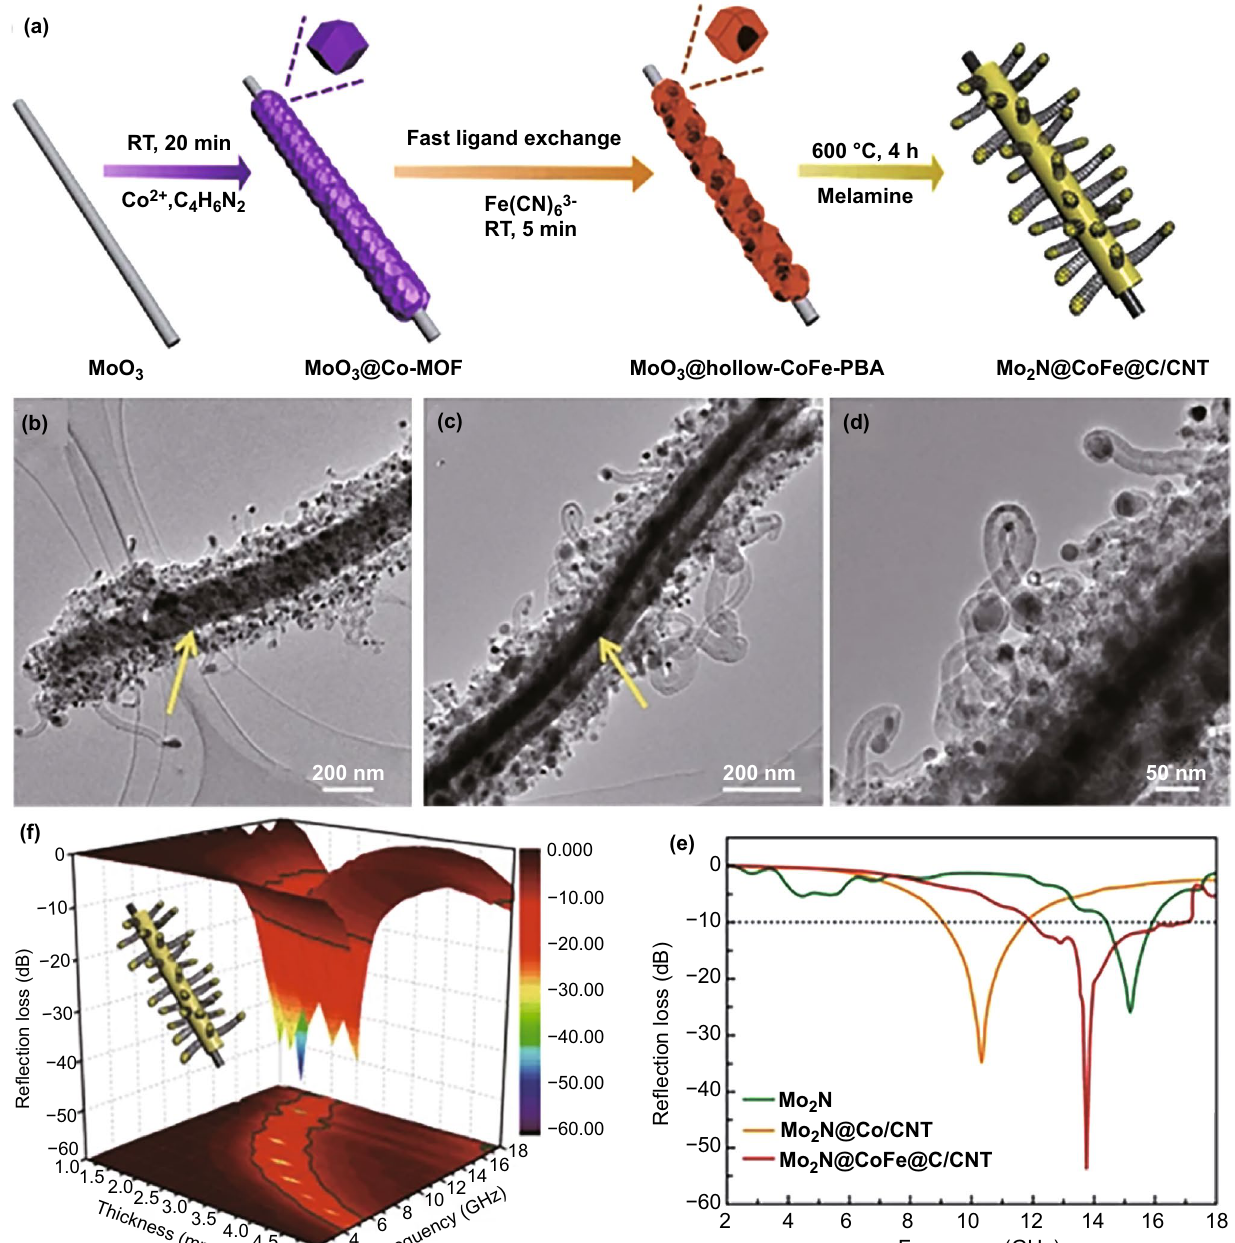
Fig. 5 a Schematic process of the fast MOF-based ligand exchange strategy for construction of 3D hierarchical Mo2N@CoFe@C/CNT com- posites. b – d TEM images of Mo2N@CoFe@C/CNT composites, and e 3D RL map, f RL curves of Mo2N@CoFe@C/CNT at the same thick- ness of 2 mm. Reproduced with permission from Ref. [105]. Copyright © 2021